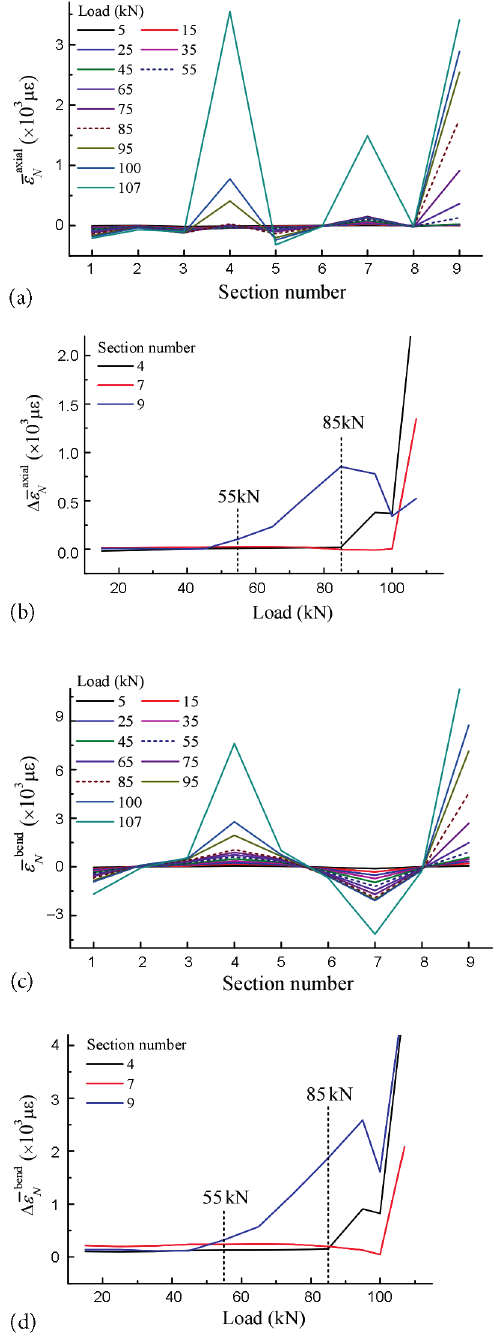
Figure 7. The stressing state sunmodes of arch D: a – the S axial - load curve; b – the axial N ∆ε -load curve; c – the S bend -load curve; d – the